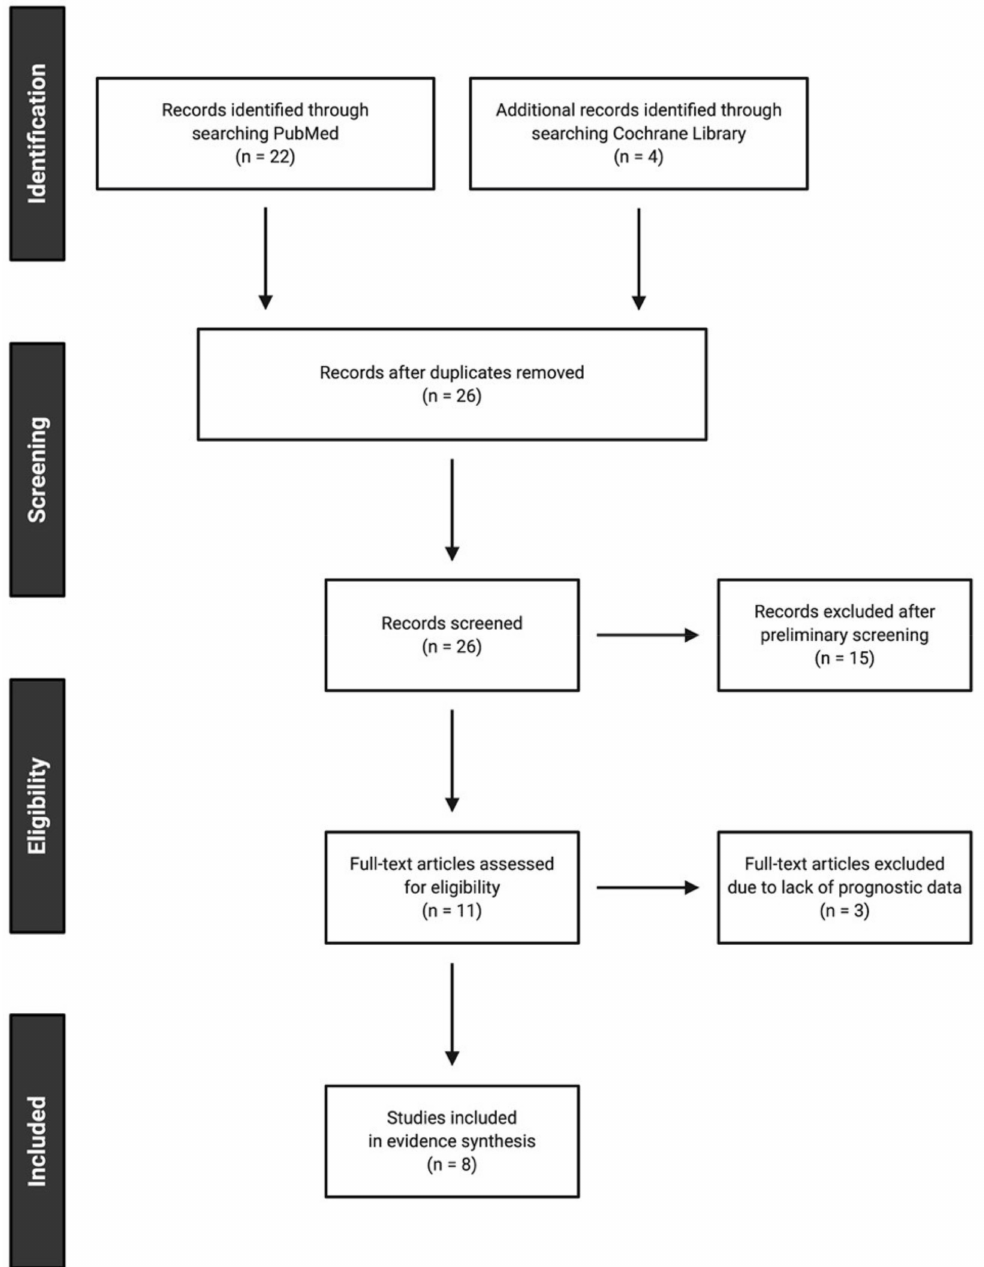
Figure 3. Flow diagram of the literature search and article selection in accordance with the preferred reporting items for systematic reviews and meta-analyses